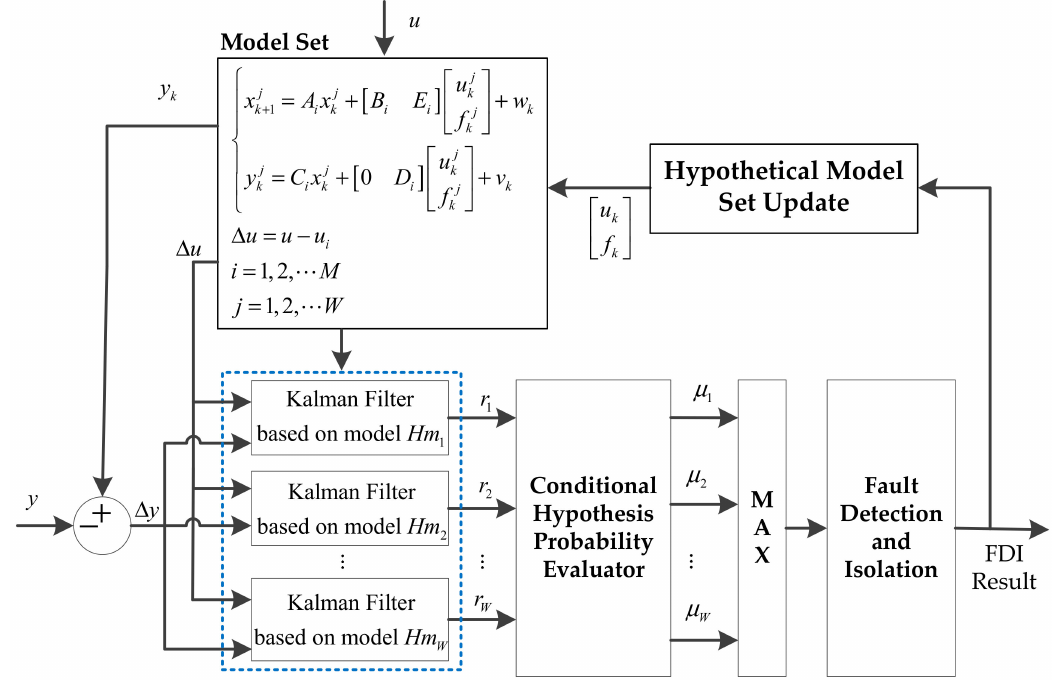
Figure 2. Diagram of the fault contribution matrix (FCM) based multiple model fault detection and isolation (MM-FDI)